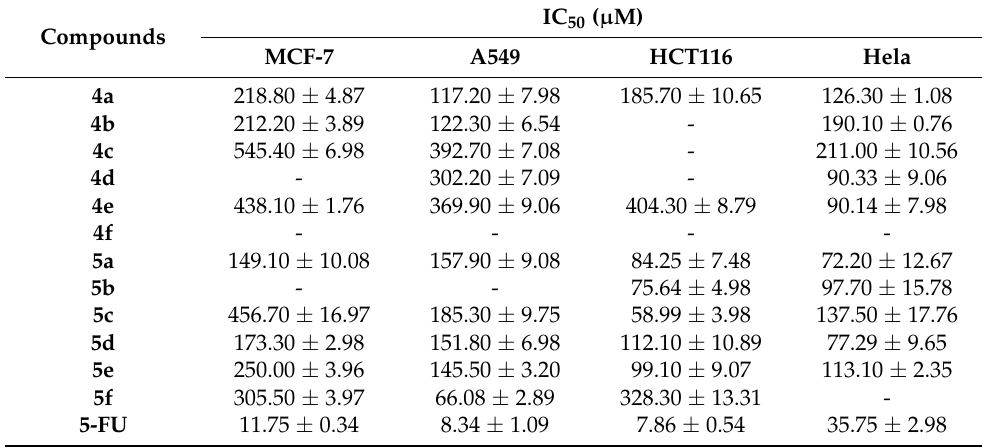
Table 2. Inhibitions of 4a – 5f against C6 and SH-SY5Y cancer cell lines after 24 h.